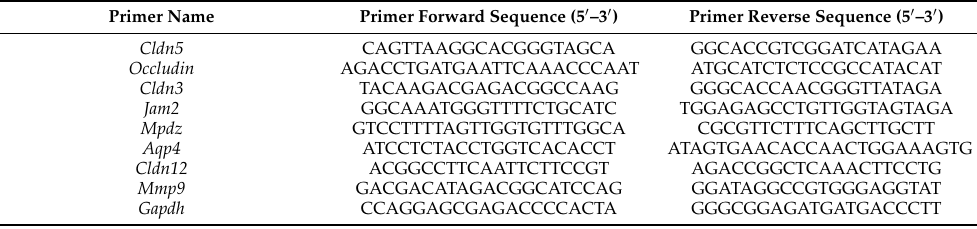
Table 1. List of primers used in this